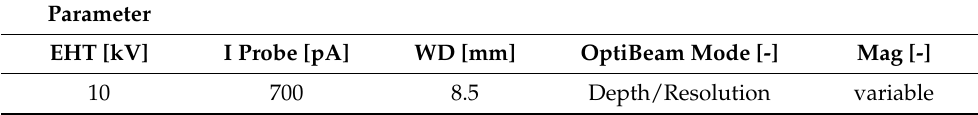
Table 1. Selected basic parameters for generating the electron images. Parameter EHT [kV] I Probe [pA] WD [mm] 8.5 Depth/Resolution